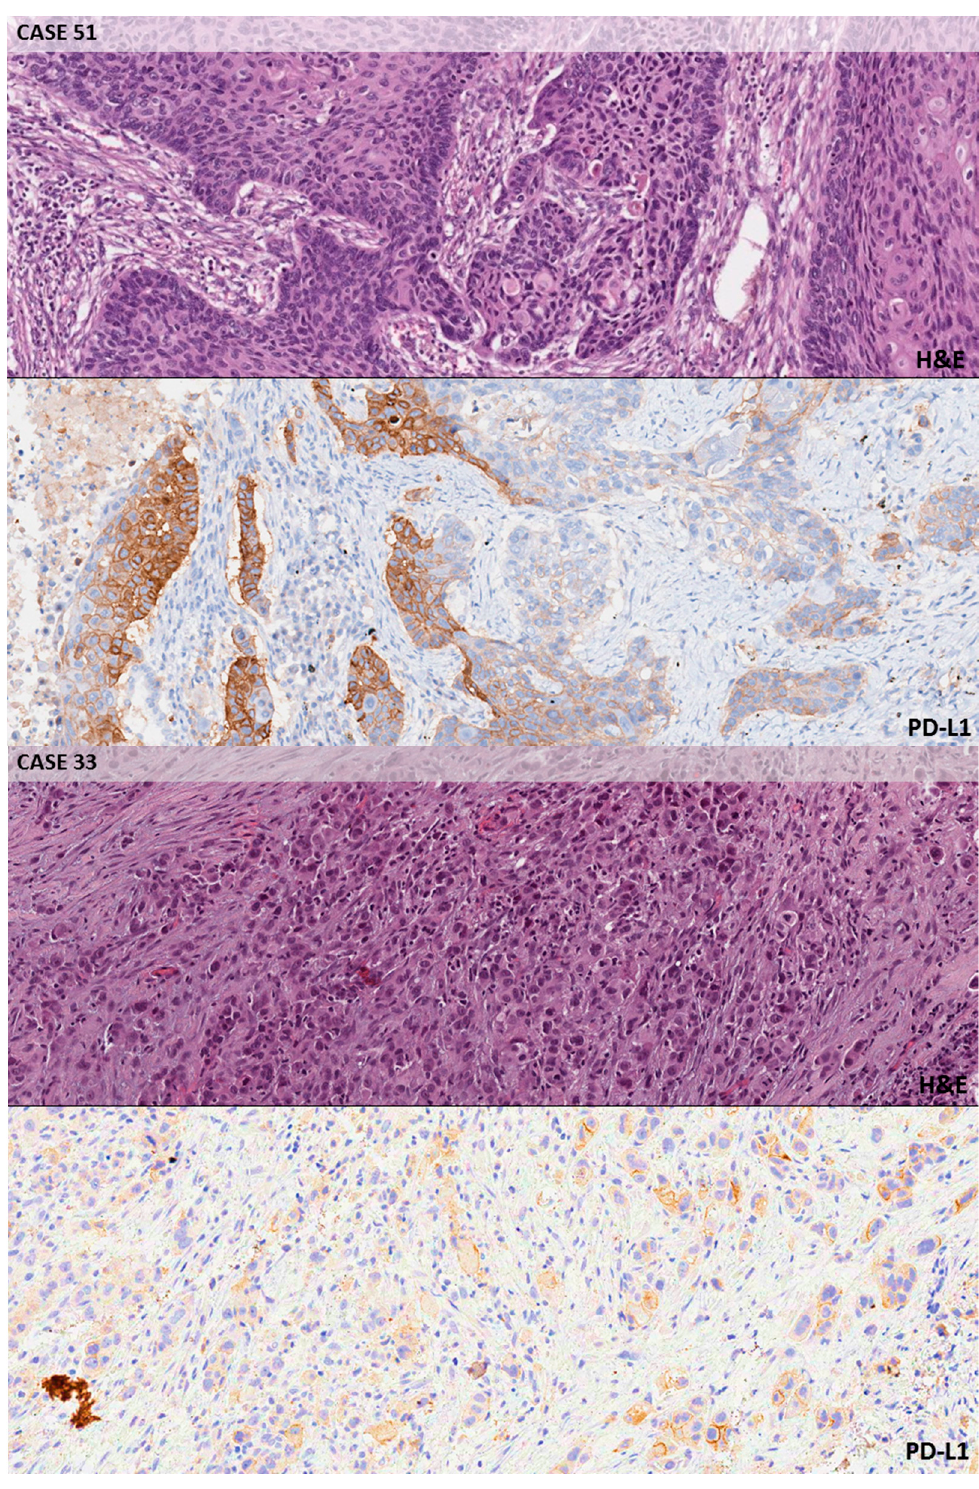
Figure 2. Intermediate and strong positive cases. Case n. 37 (10×, SP263): PD-L1 TPS > 50%; heterogeneous PD-L1 expression throughout the same tumor, with areas only showing faint background staining in non-neoplastic cells (bottom row, left) along with areas characterized by strong and complete membrane staining in the cancerous elements (bottom row, right). A challenging decision was jointly obtained to decide the exact threshold. Case n. 14 (10×, 22c3): PD-L1 TPS > 50%; all participants correctly ascribed this case to the ‘strong expression’ category due to the diffuse presence of PD-L1 staining in the tumor cells. Case n. 51 (10×, SP263): PD-L1 TPS 1–49%; heterogeneous PD-L1 expression with strong staining cells closely intermixed with faintly staining or negative cells. Case n. 33 (10×, 22C3): PD-L1 TPS 1–49%; a few of the neoplastic elements from this